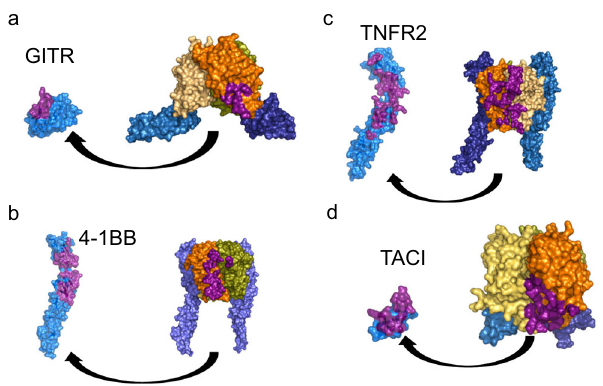
Fig. 8 Comparison of TNF – TNFR complexes highlights minimal GITR interface. a hGITR – hGITRL (380 Å 2 interface). b h4-1BB – h4-1BBL (6MGP, 950 Å 2 interface). c hTNFa – hTNFR2 (3ALQ, 1330 Å 2 interface). d mAPRIL – hTACI (1XU1, 880 Å 2 interface). Interactions are shown for surfaces of trimeric ligands (orange, tan, and olive) and receptors (light blue, deep teal, and marine), with single receptor removed to show receptor – ligand interface